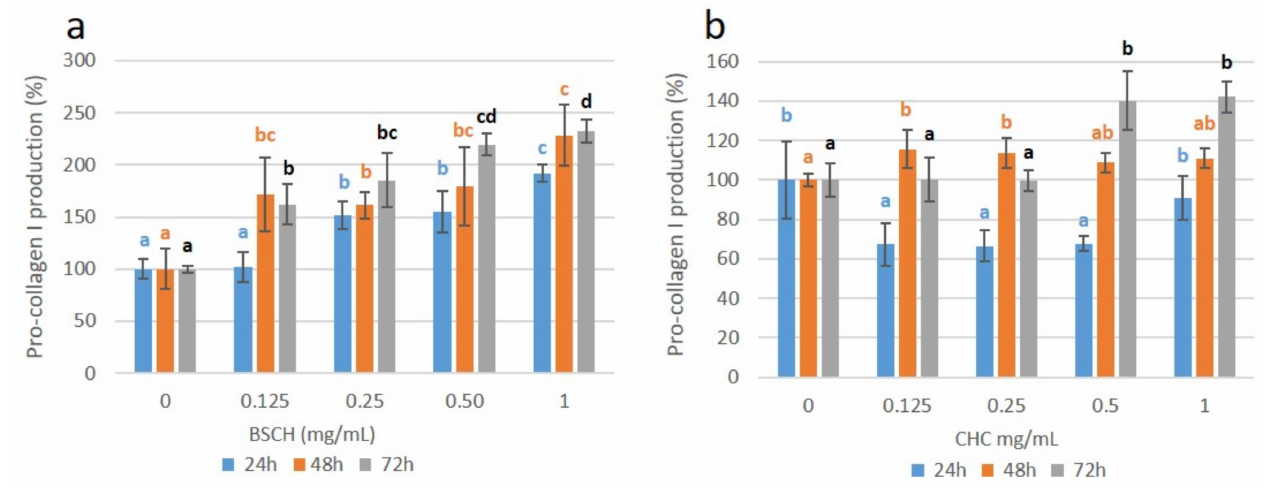
Figure 6. Pro-collagen I production for the fibroblast cell cultures treated with BSCH-C ( a ) and CHC ( b ) hydrolysates and normalized to the control group. Values are shown as means with standard deviation. Different letters indicate significant differences between concentration groups ( p < 0.05).